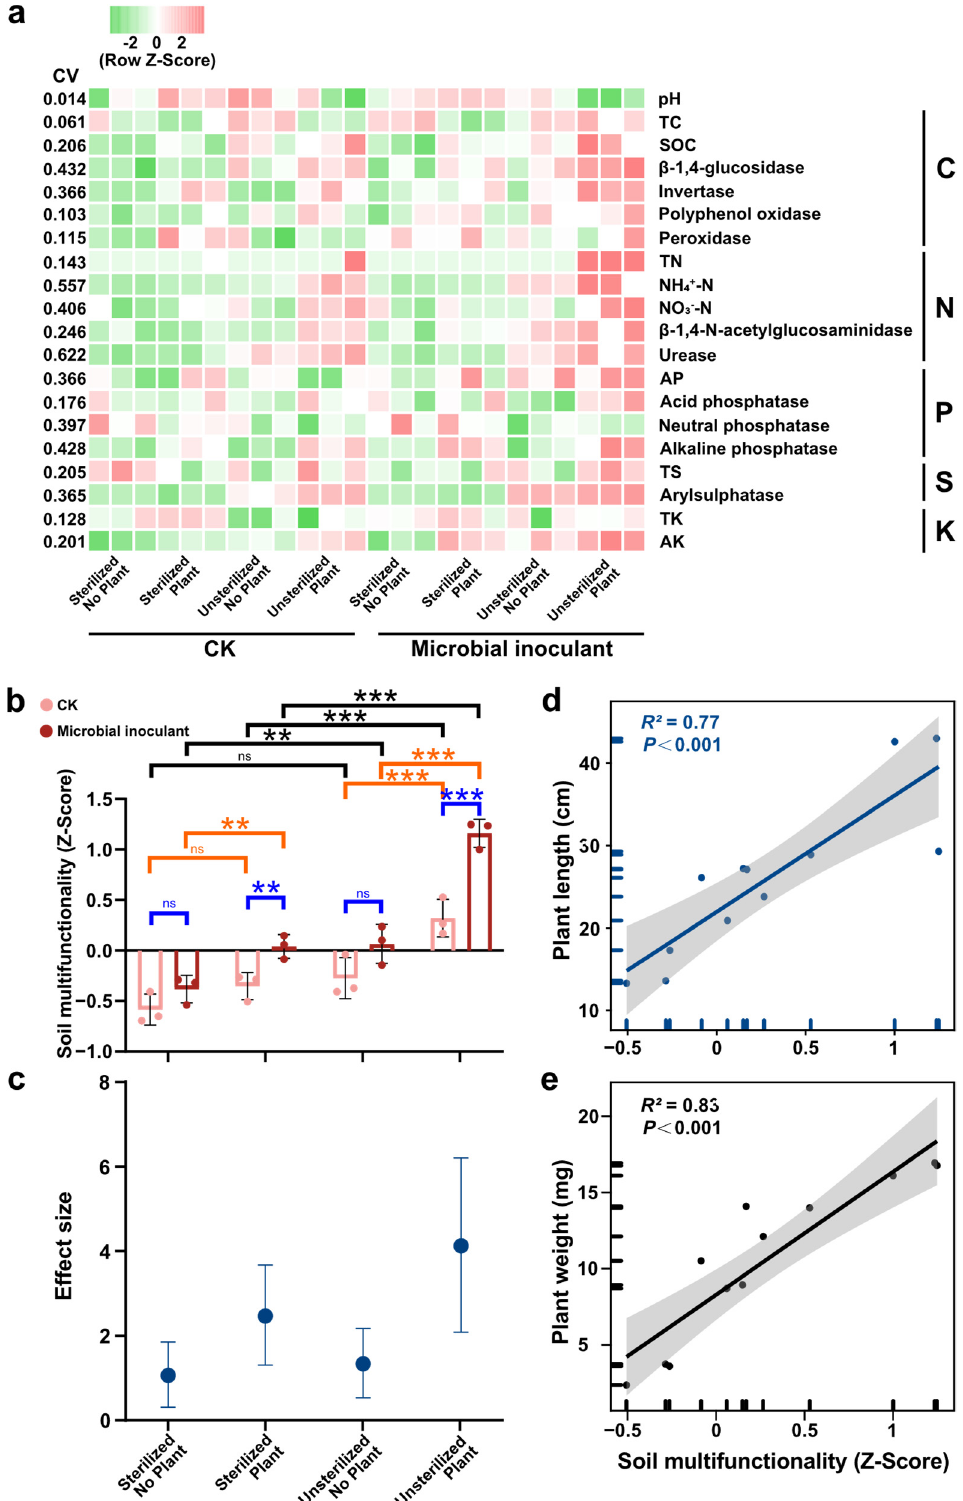
Figure 2. ( a ) Heat map showing the change in soil nutrients and enzyme activities under different treatments. ( b ) soil multifunctionality indices under different treatments. ( c ) the effect size of microbial inoculant on soil multifunctionality under the background of the plant and native microor- ganisms. ( d , e ) correlation of soil multifunctionality with plant length and dry weight. Note: ns indicates no significant effect, ** indicates p < 0.01, and *** indicates p <